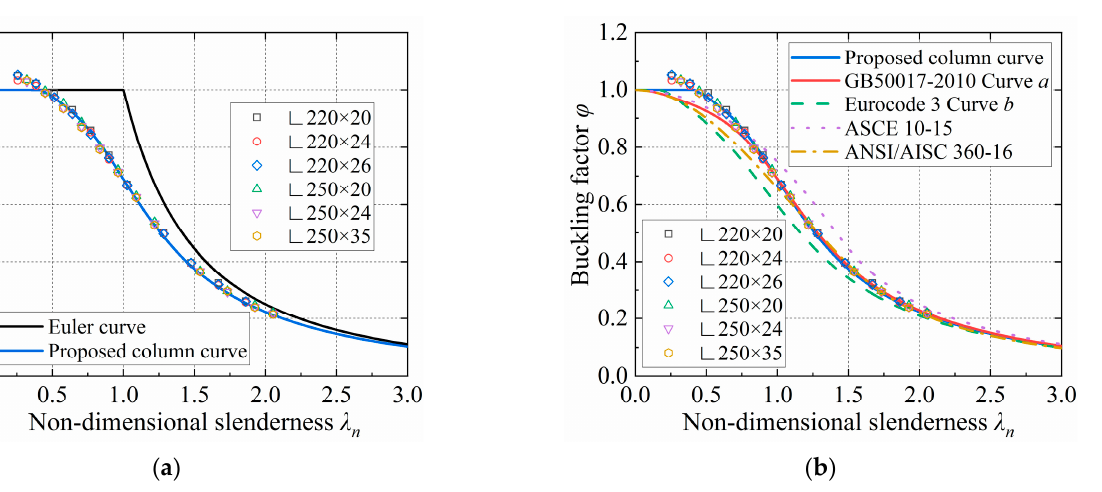
Figure 16. Comparison of the proposed column curve with FE results and design curves: ( a ) FE results; ( b ) Design curves.